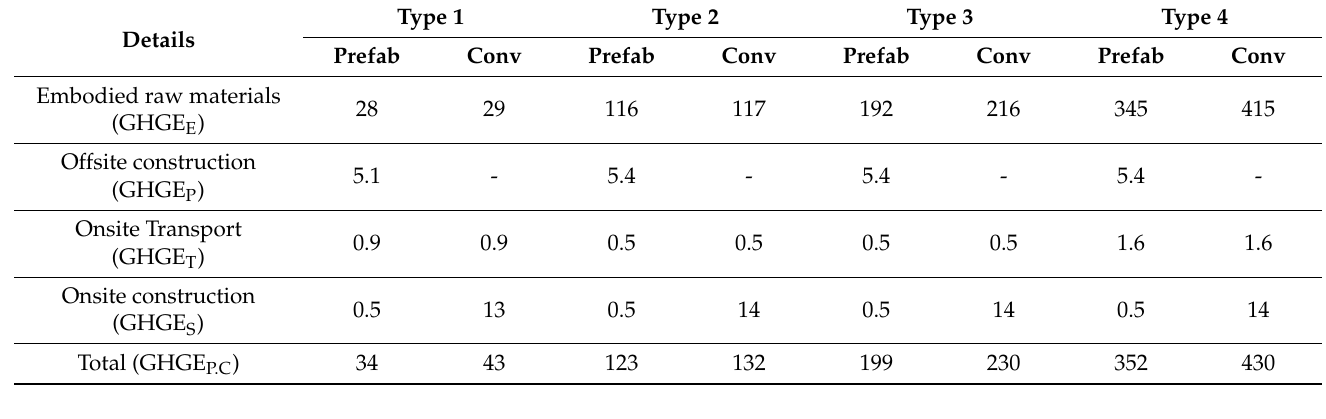
Table 6. Comparison of GHGE between conventional and prefabricated constructions.